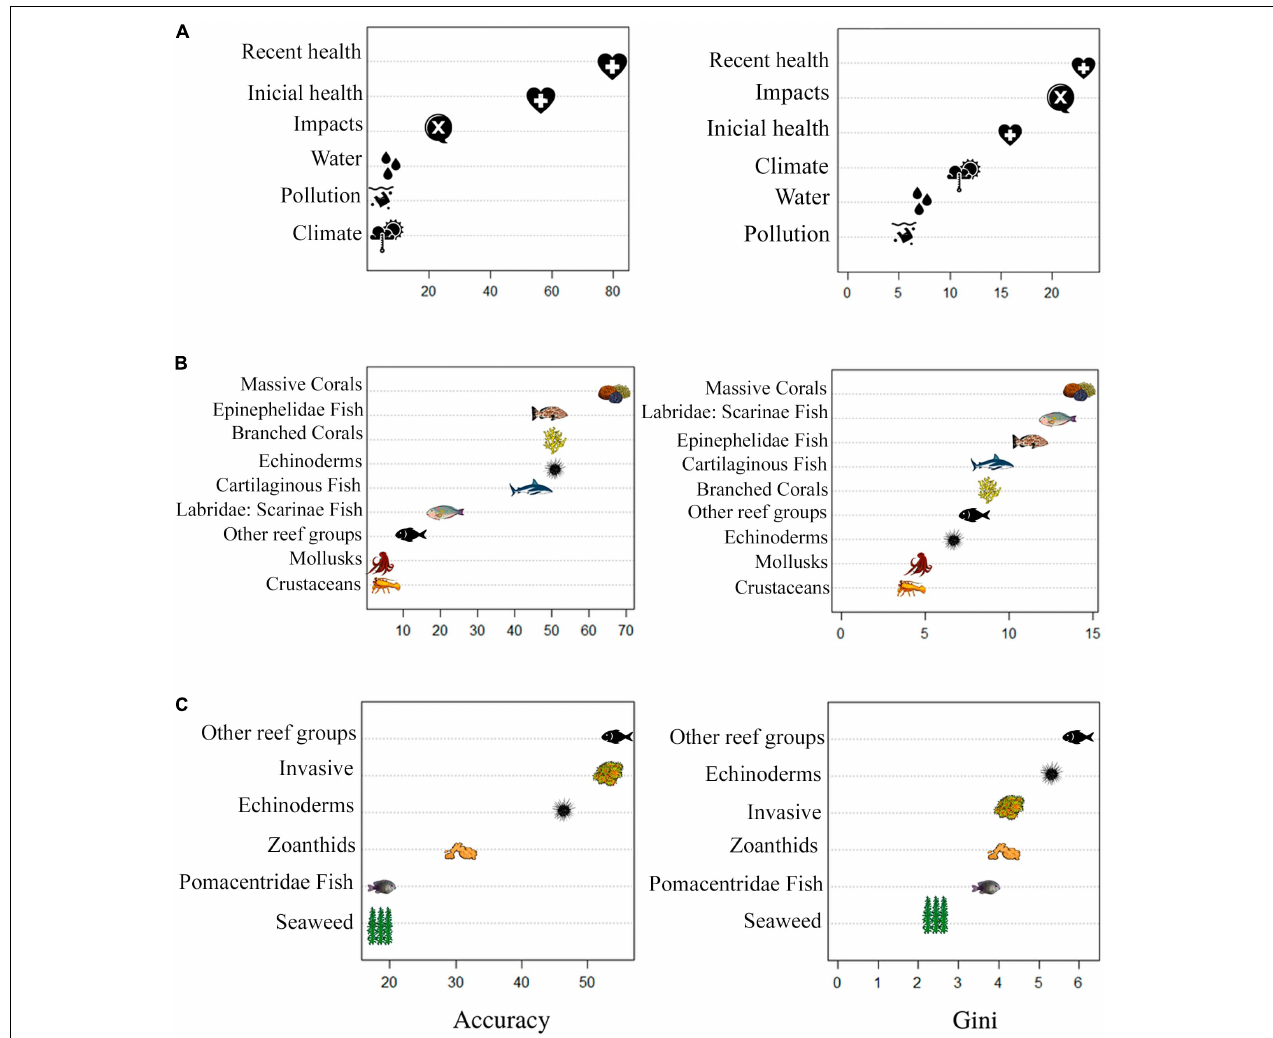
FIGURE 3 | Random Forest accuracy and Gini values showing the main variables responsible for the differences in stakeholder perception on. (A) Changes in abiotic reef environment. (B) Organisms that have decreased. (C) Organisms that have increased in reef landscapes. Notice that the higher the accuracy or the Gini value, the more likely it is that that variable contributed to separating the stakeholders according to their